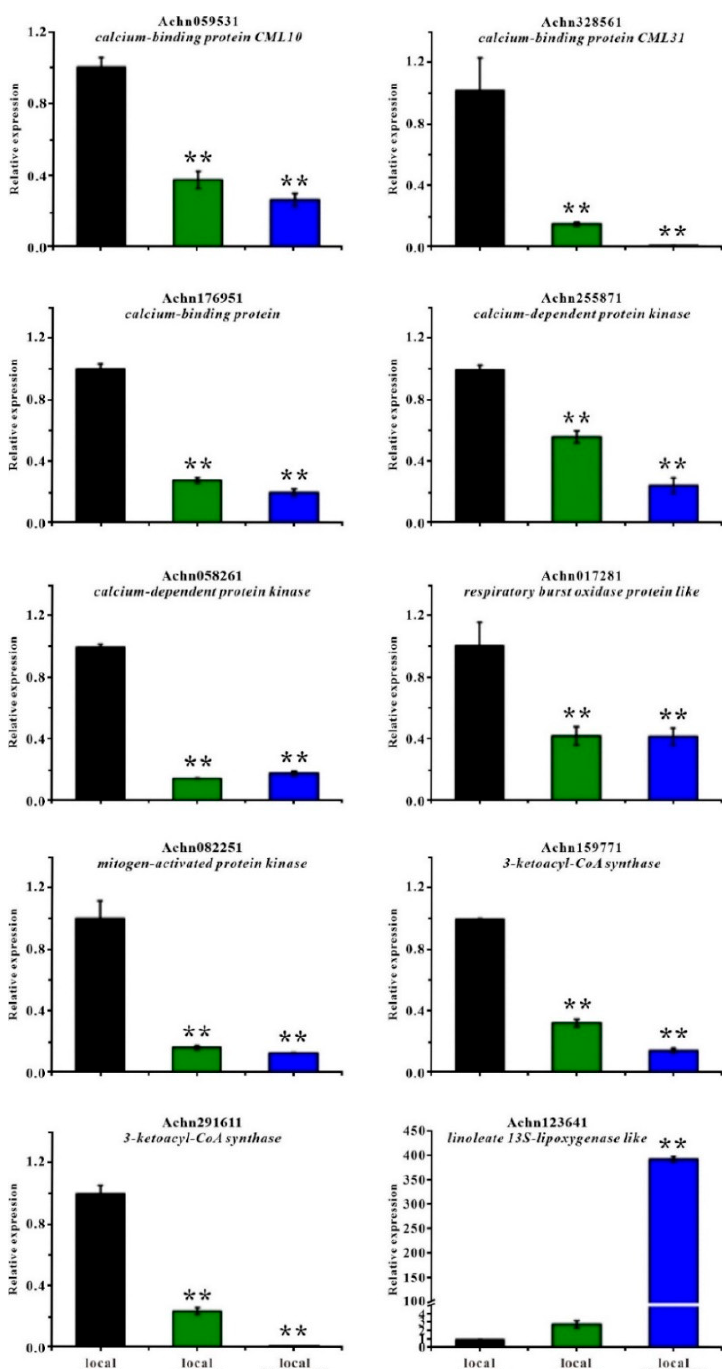
Figure 5. Validation of gene expressions in Psa -inoculated ‘Hongyang’ by RT-qPCR. Ten differen- tially expressed kiwifruit genes in transcriptomic analysis, encoding calcium-binding protein CML10 (Achn059531), calcium-binding protein CML31 (Achn328561), calcium-binding protein (Achn176951), calcium-dependent protein kinase (Achn255871, Achn058261), respiratory burst oxidase protein like (Achn017281), mitogen-activated protein kinase (Achn082251), 3-ketoacyl-CoA synthase (Achn159771, Achn291611) and linoleate 13S-lipoxygenase like (Achn123641), were determined for RT-qPCR in mock, ScPzH, or ScGyH2 inoculated stem tissues at inoculation sites (local ‘mock’, local ‘ScPzH and local ‘ScGyH2 (cid:48) , respectively) at 14 dpi. Significant differences compared with ‘mock’ were analyzed using Student’s t -test: ** p <